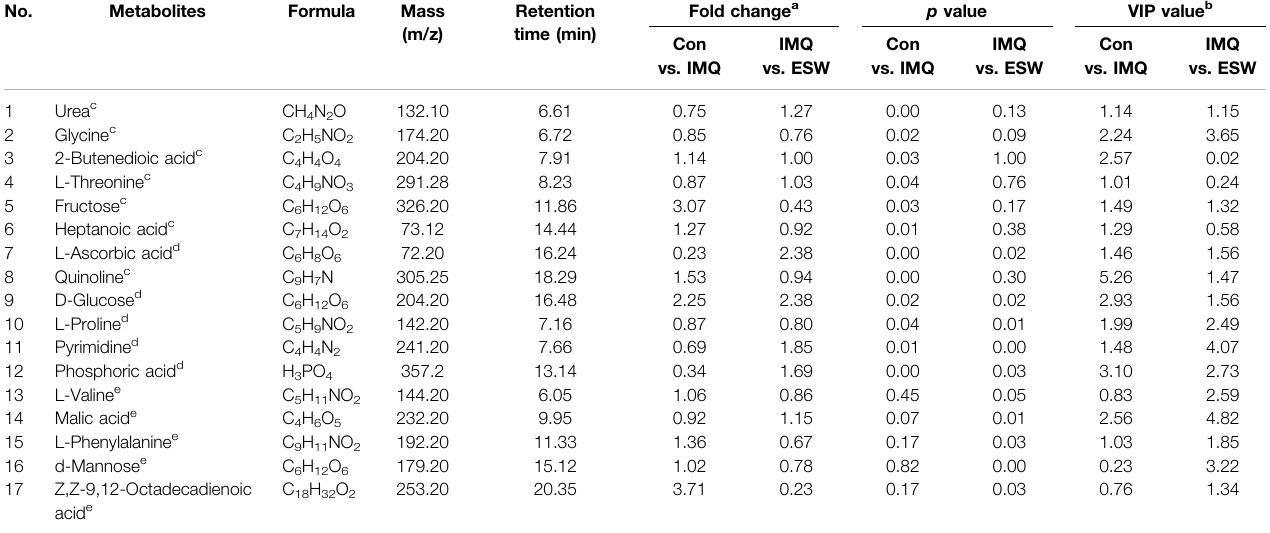
TABLE 2 | Summary of potential metabolites in the spleen. No.